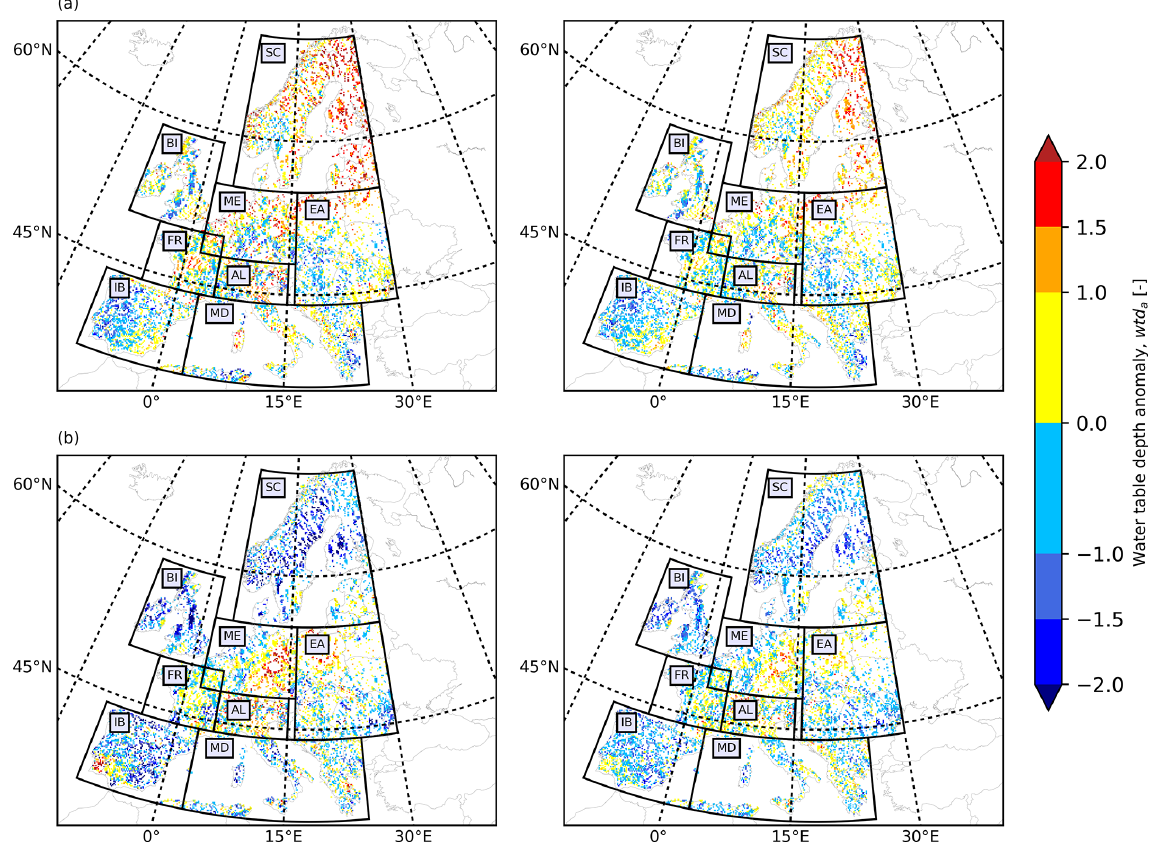
Figure 5. European wtd a maps for (a) August 2003 (i.e., in the training period) and (b) August 2015 (i.e., in the testing period) derived from the TSMP-G2A data set (left) and the results from LSTM networks (right).